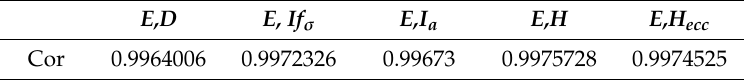
Table 7. The correlation between graph energy and entropies applied to A 12 n + 4 .